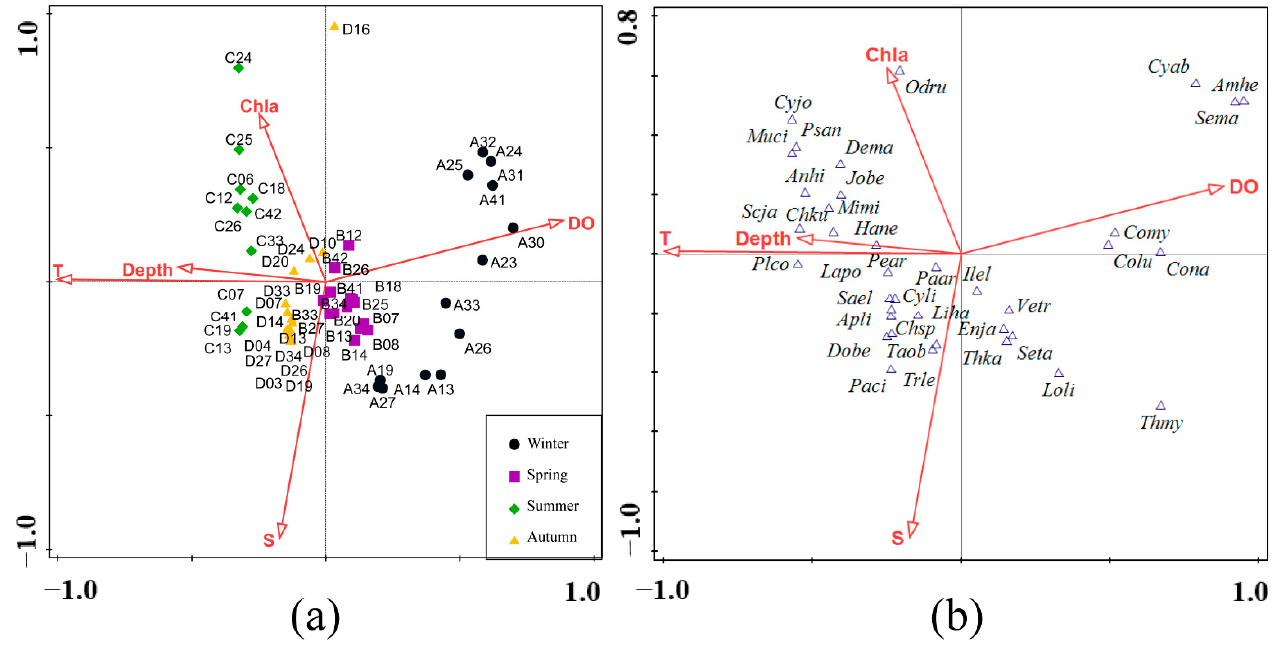
Figure 7. CCA plots of fish assemblages ( a ) and species ( b ) associated with environmental variables adjacent to the Yangtze Estuary. Seta : Setipinna taty ; Comy : Coilia mystus ; Loli : Lophius litulon ; Cona : Coilia nasus ; Paar : Pampus argenteus ; Trle : Trichiurus lepturus ; Vetr : Vespicula trachinoides ; Thka : Thryssa